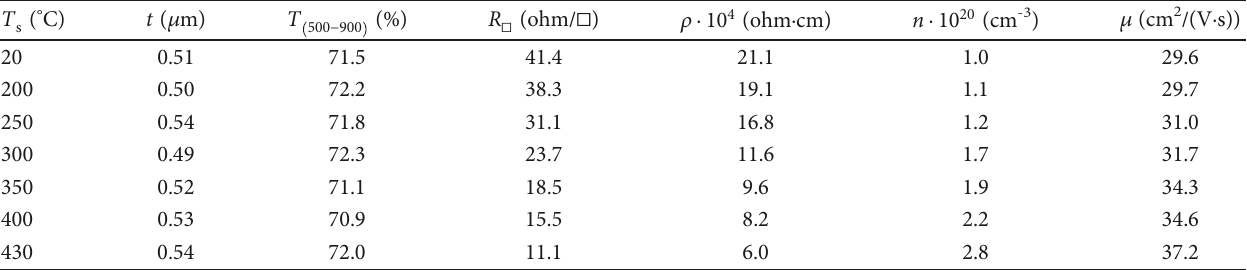
Table 3: E ff ect of annealing in air on the optical and electrical properties of ITO layers obtained at di ff erent substrate temperatures. ° Т s (